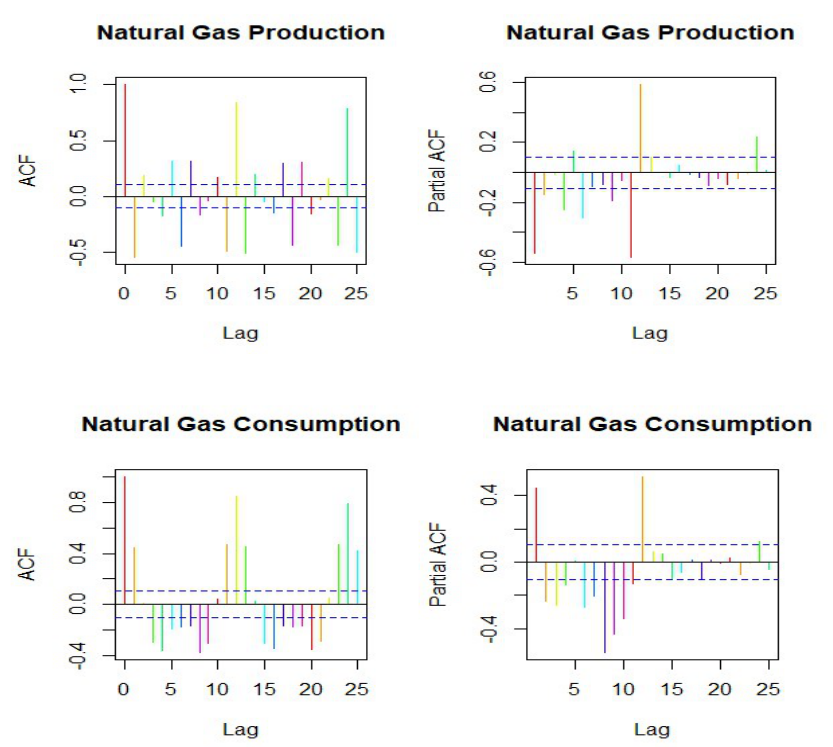
Figure 3. Results of ACF and PACF diagrams for a selection of parameter AR ( p ) and MA( q ) in natural gas production and consumption.